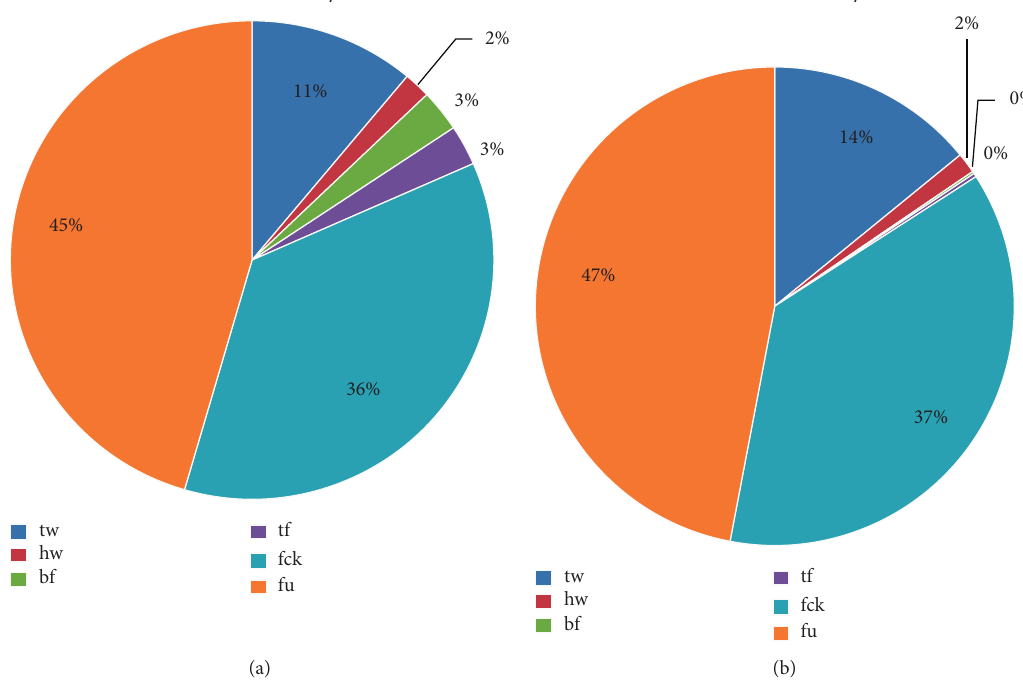
Figure 15: First-order and total Sobol’s sensitivity indices of the 50-year corroded SCC